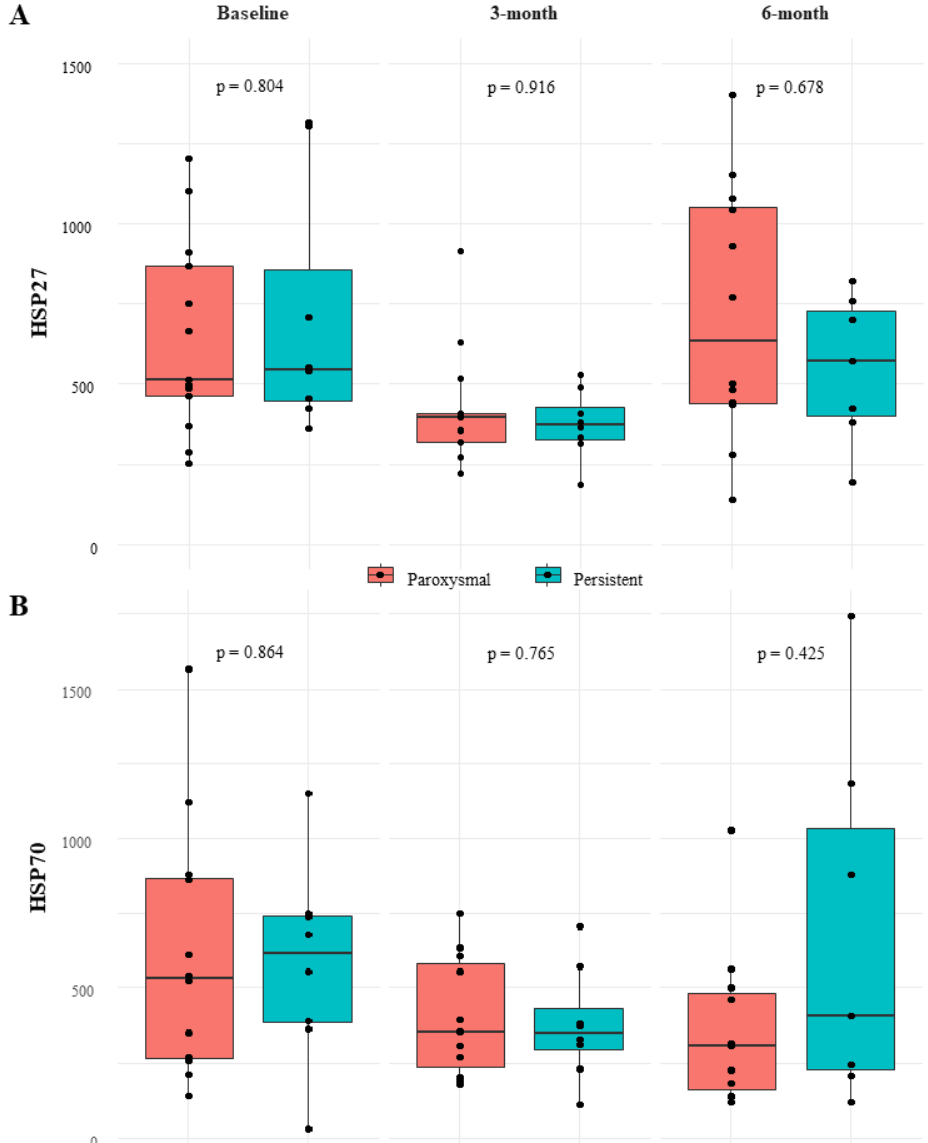
Figure 4. HSP levels for paroxysmal and (longstanding) persistent AF patients. ( A ): Boxplots of HSP27 levels for paroxysmal and (longstanding) persistent AF patients separately during the study period. ( B ): Boxplots of HSP70 levels for paroxysmal and (longstanding) persistent AF patients separately during the study period.